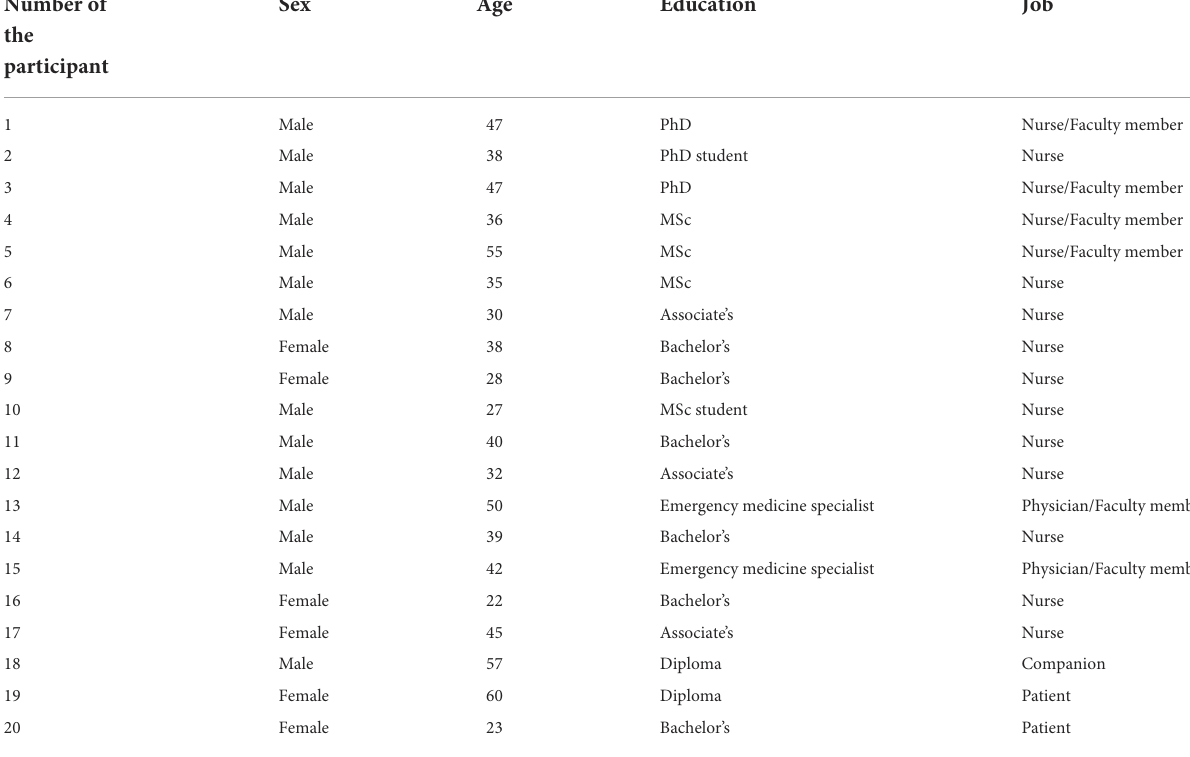
TABLE 1 Demographic characteristics of the participants. Number of